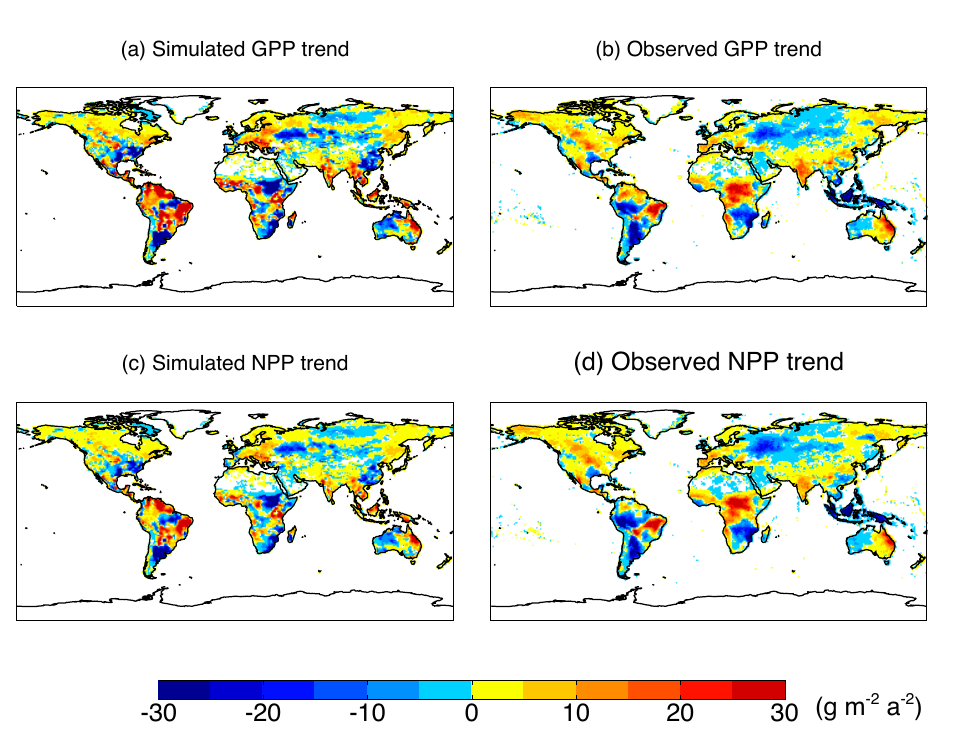
Figure 3. Comparisons of trends in (a, b) GPP and (c, d) NPP for 2000–2011 between (a, c) simulations and (b, d) observations. Observed fluxes are retrieved from the Moderate Resolution Imaging Spectroradiometer